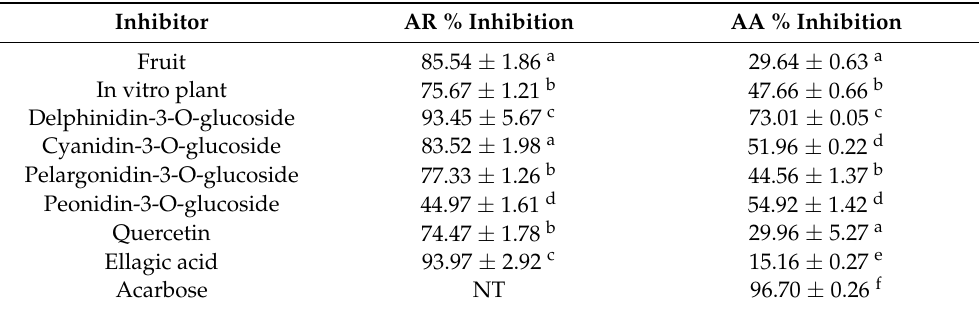
Table 6. Inhibition of bovine aldose reductase (AR) and pancreatic alpha ‐ amylase (AA) enzymes for aqueous extracts of fruit and in vitro plant of A. chilensis and aqueous solutions of the anthocy ‐ anins and phenolic compounds standards. Mean ± standard deviation.